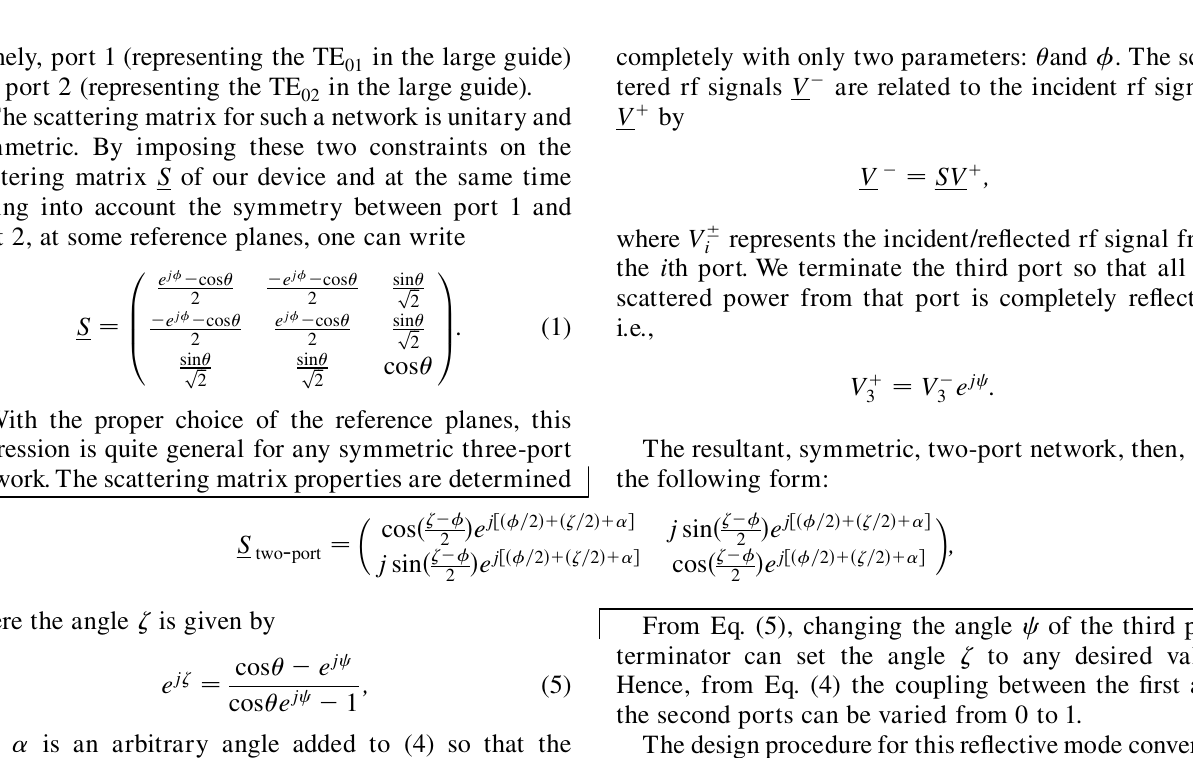
FIG. 1. (Color) Dual-moded delay